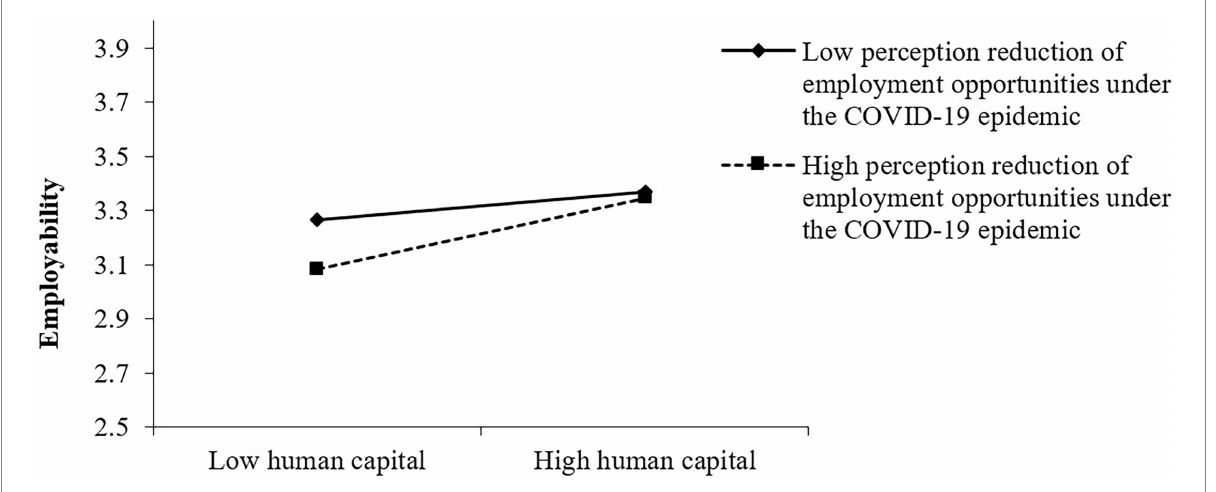
FIGURE 2 The moderating effect of perception reduction of employment opportunities under the epidemic on human capital and employability.